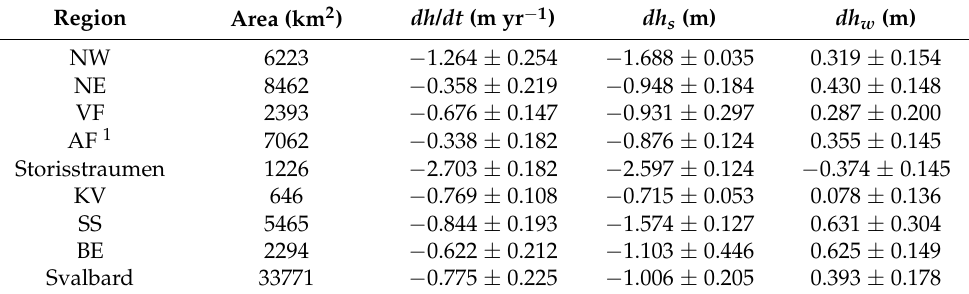
Figure 3. Hypsometries for each subregions (Figure 1) and for the whole Svalbard. The red points indicate the mean dh / dt values, the error bars are the standard deviation of dh / dt values, the blue dashed line indicates fourth-order fitting trend line for all mean dh/dt values. The blue bars are the Glacier area and the gray bars represent the number of dh/dt observations per elevation bin. Table 1. Glacier area, number of the points, annual elevation change rates ( dh / dt ), summer eleva- tion changes ( dh s ) and winter elevation changes ( dh w ) for each subregion and the entire region of